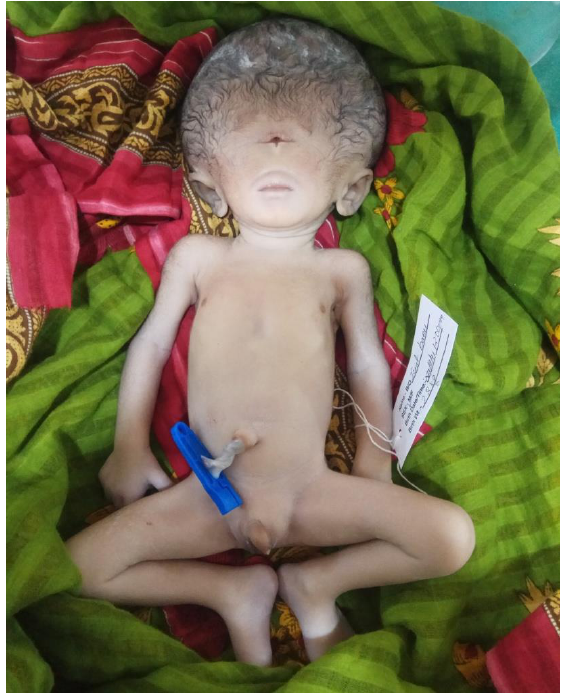
Figure 1: Cyclopic